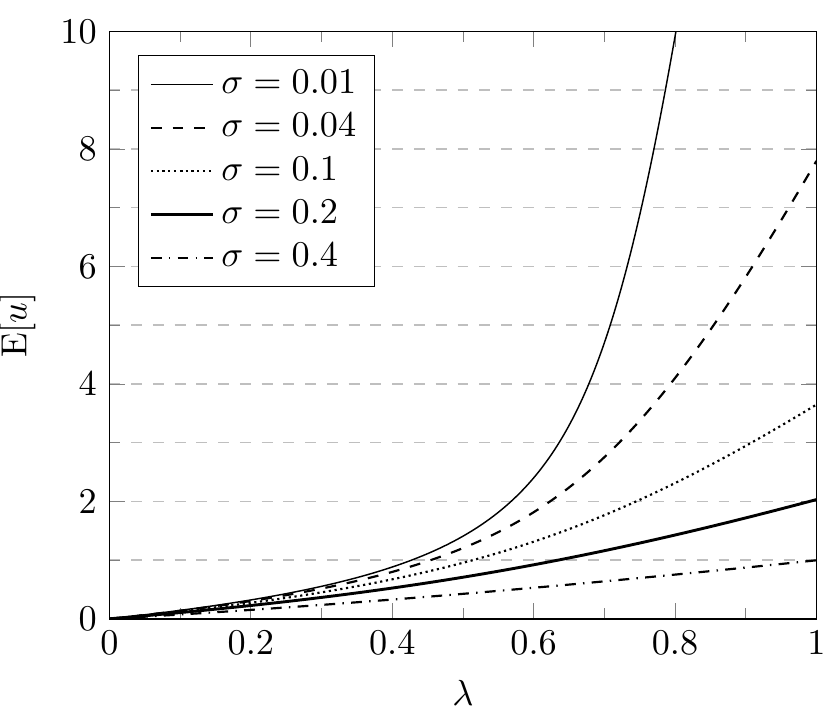
Figure 1. Mean system content E [ u ] versus λ , for Poisson arrivals, geometric service times with µ = 0.75 and different values of σ .